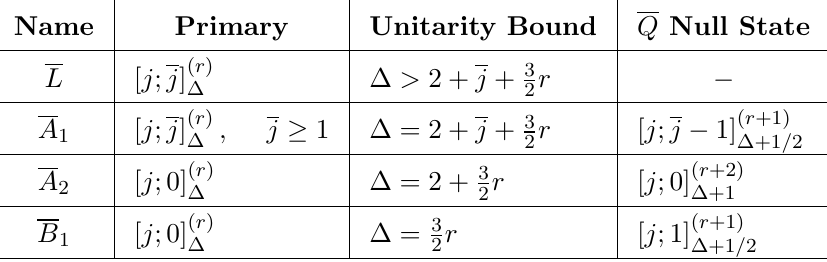
Table 11 . Q shortening conditions in four-dimensional N = 1 SCFTs.